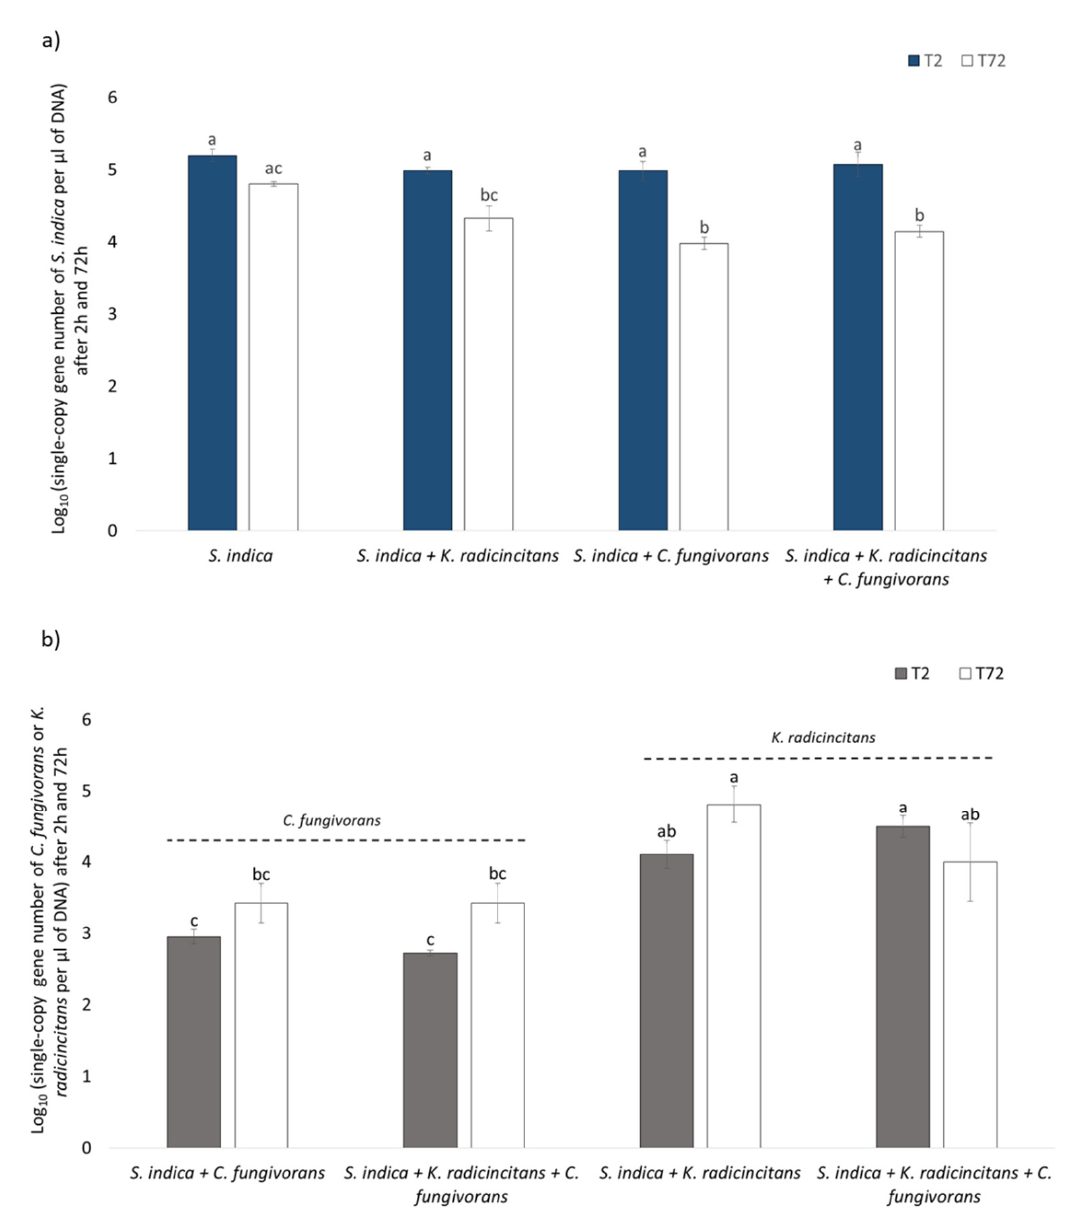
Figure 6. ( a ) Average log 10 transformed single-copy gene numbers of S. indica (per µL of DNA) when co-cultivated with K. radicincitans , C. fungivorans, or both, 2 h and 72 h post inoculation. ( b ) Average log 10 transformed single-copy gene numbers of C. fungivorans and K. radicincitans (per µL of DNA) when co-cultivated with S . indica , 2 h and 72 h post inoculation. Different letters above bars represent significant differences ( p < 0.05) according to two-way ANOVA, using treatment and time as factors followed by a Tukey’s range test. Error bars indicate standard deviation of means of six different replicates .